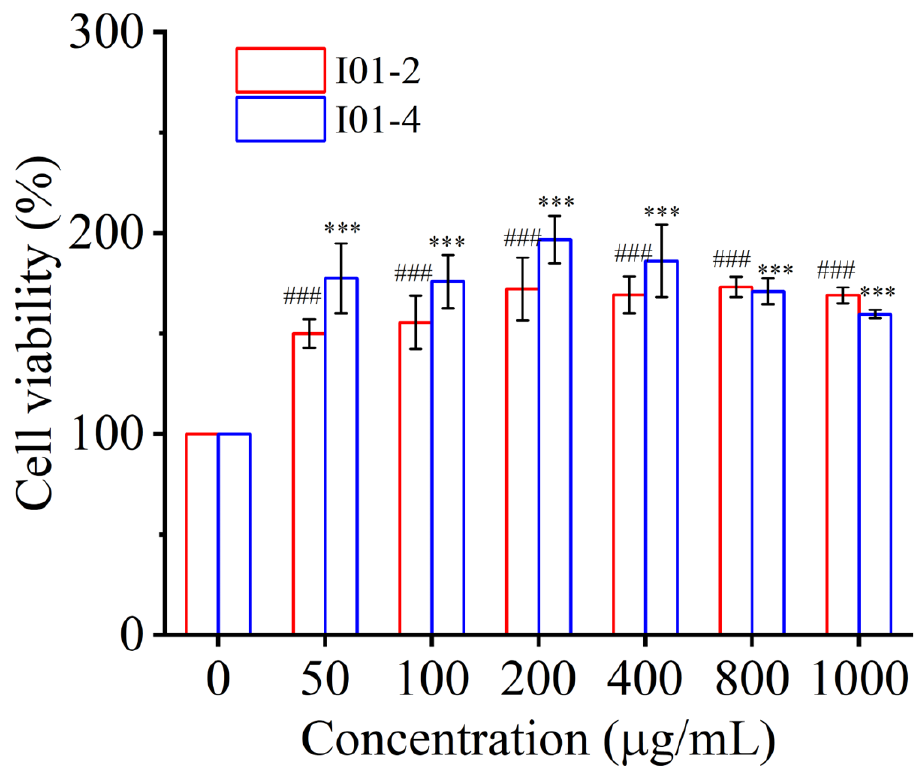
Figure 4. The effect of I01-2 and I01-4 on the viability of RAW 264.7 cells. Data were expressed as mean ± SEM. *** p < 0.001 (vs. I01-4 at concentrations of 0 μ g/mL), ### p < 0.001 (vs. I01-2at concentrations of 0 μg/mL).